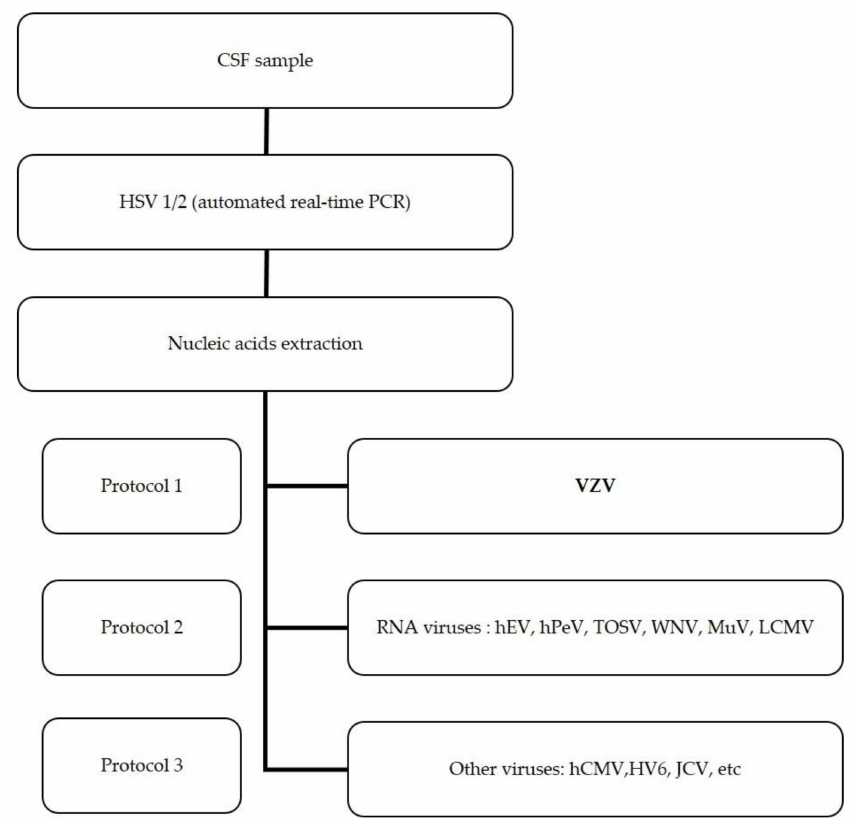
Figure 1. Algorithm of the molecular detection of viruses involved in acute meningitis and encephali- tis. Protocols 1–3 were simultaneously performed from the nucleic acids extract after HSV 1 and were discarded. Real-time PCR and RT-PCR were carried out for the detection of DNA and RNA viruses,